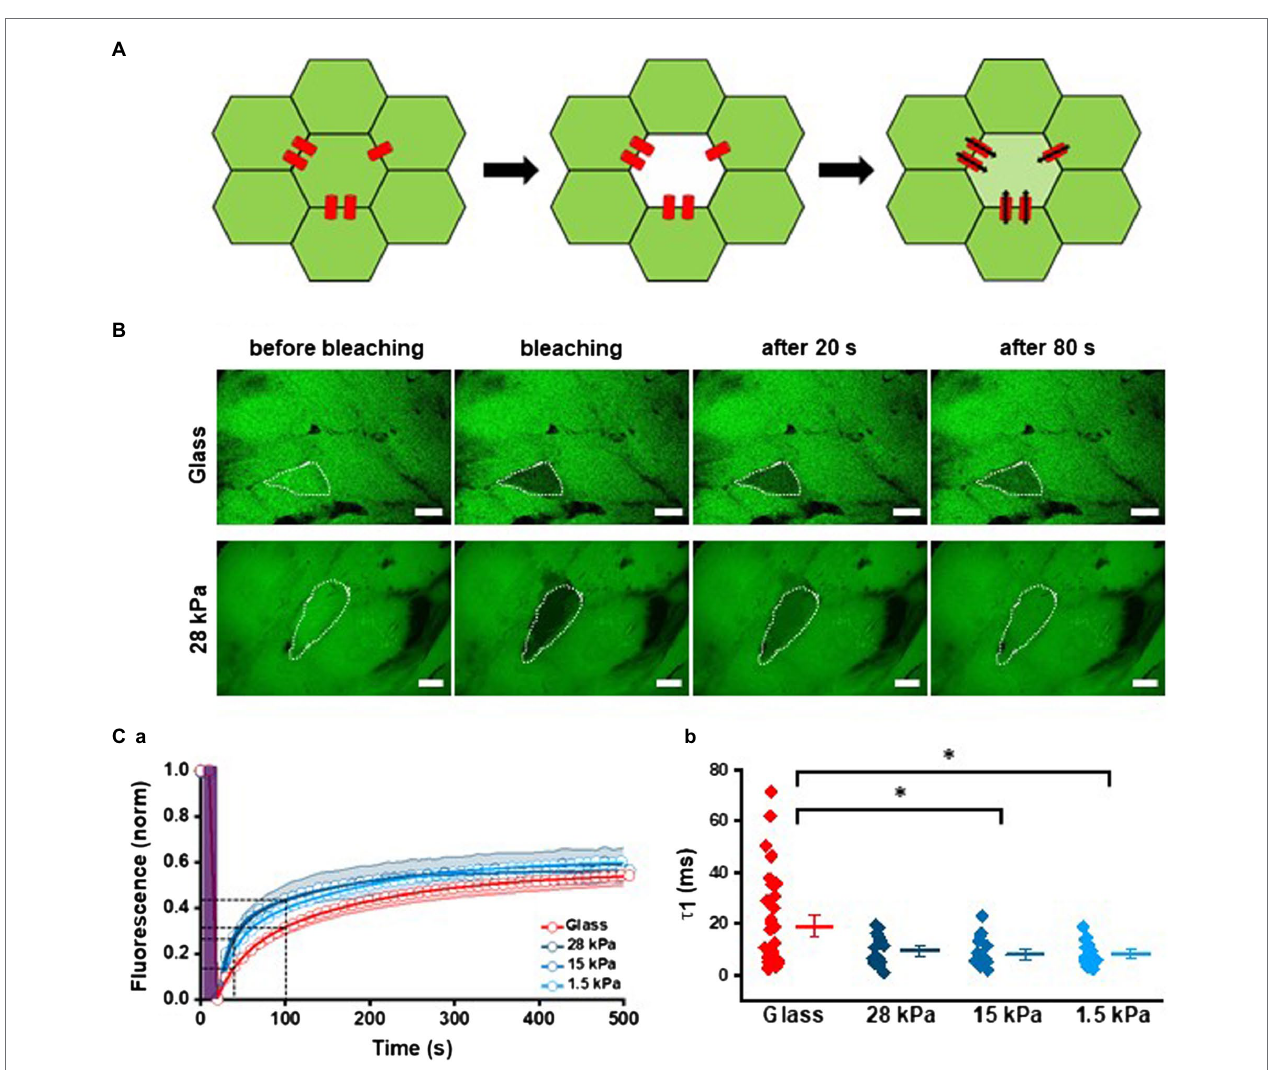
FIGURE 6 | Enhanced intercellular coupling on soft surfaces. (A) Schematic illustration of FRAP experiments. Left: the cell layer is stained with calcein (shown in green). Middle: one cell within a cell cluster is bleached by high laser power (5 s). Right: after bleaching recovery of fluorescence by calcein diffusion through gap junctions from neighbored cells is monitored over time. (B) Representative FRAP experiments with iPSC-CMs grown on glass and 28 kPa. The target cell is marked by a white dotted line. The first image corresponds to t = 0 s before bleaching, and the second image was taken at t = 20 s immediately after bleaching. At t = 40 s and 100 s, the third and fourth images were taken. (Ca) Average time courses of FRAP for each stiffness were plotted and fitted with a biexponential function. FRAP was significantly faster in iPSC-CMs grown on all PDMS-coated surfaces compared to glass. (Cb) Statistical evaluation of tau1 ( τ 1). For cells grown on glass n = 35; for 28 kPa-PDMS n = 15; for 15 kPa-PDMS n = 17; and for 1.5 kPa-PDMS n =